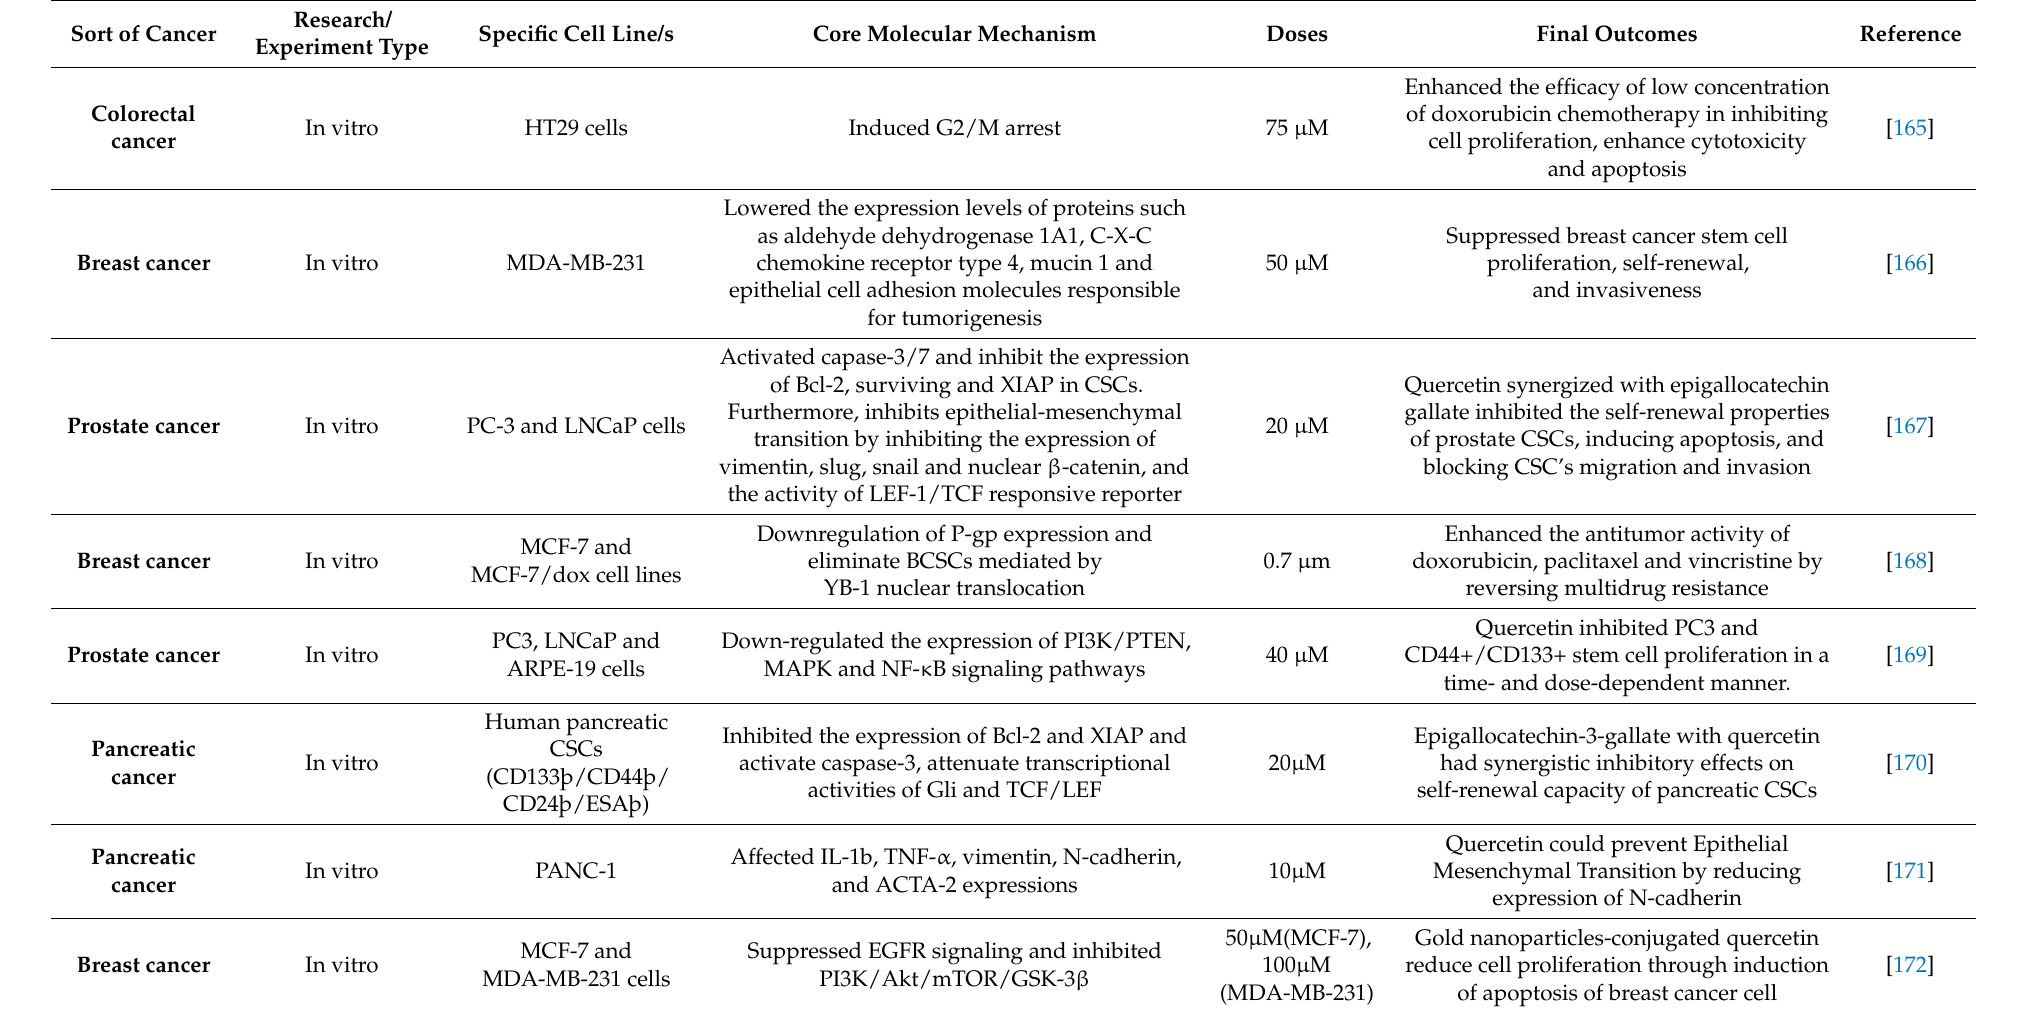
Table 2. Tabular representation of quercetin-mediated cancer stem cell killing with their mechanistic